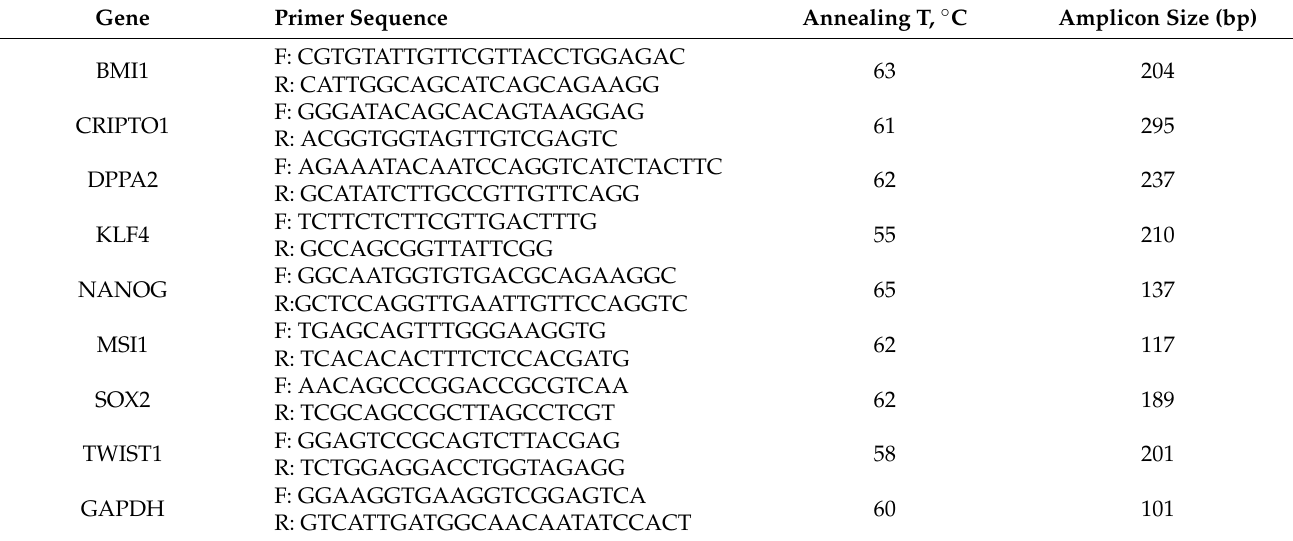
Table 1. Primer sequences used in real-time PCR.